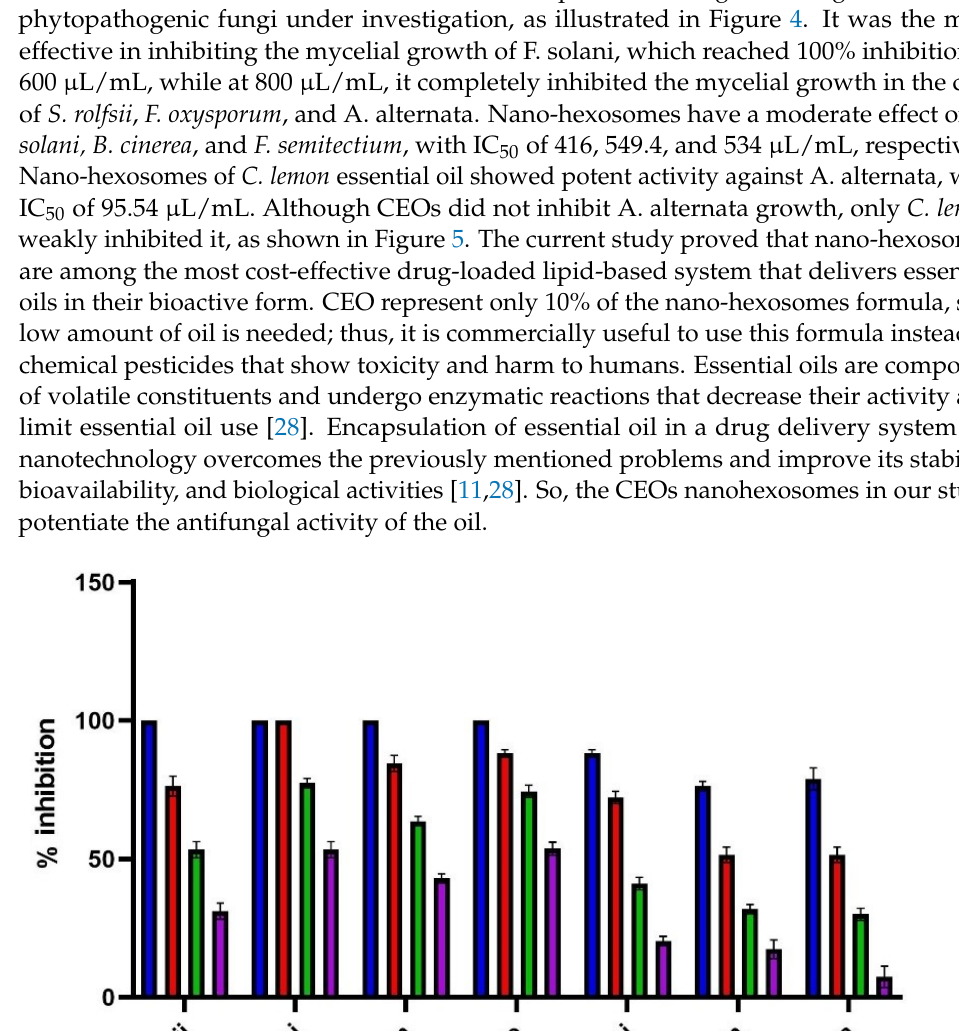
Figure 5. Mycelial growth % inhibition of Citrus lemon essential oil and its nano-hemosome formula . 3. Materials and Methods